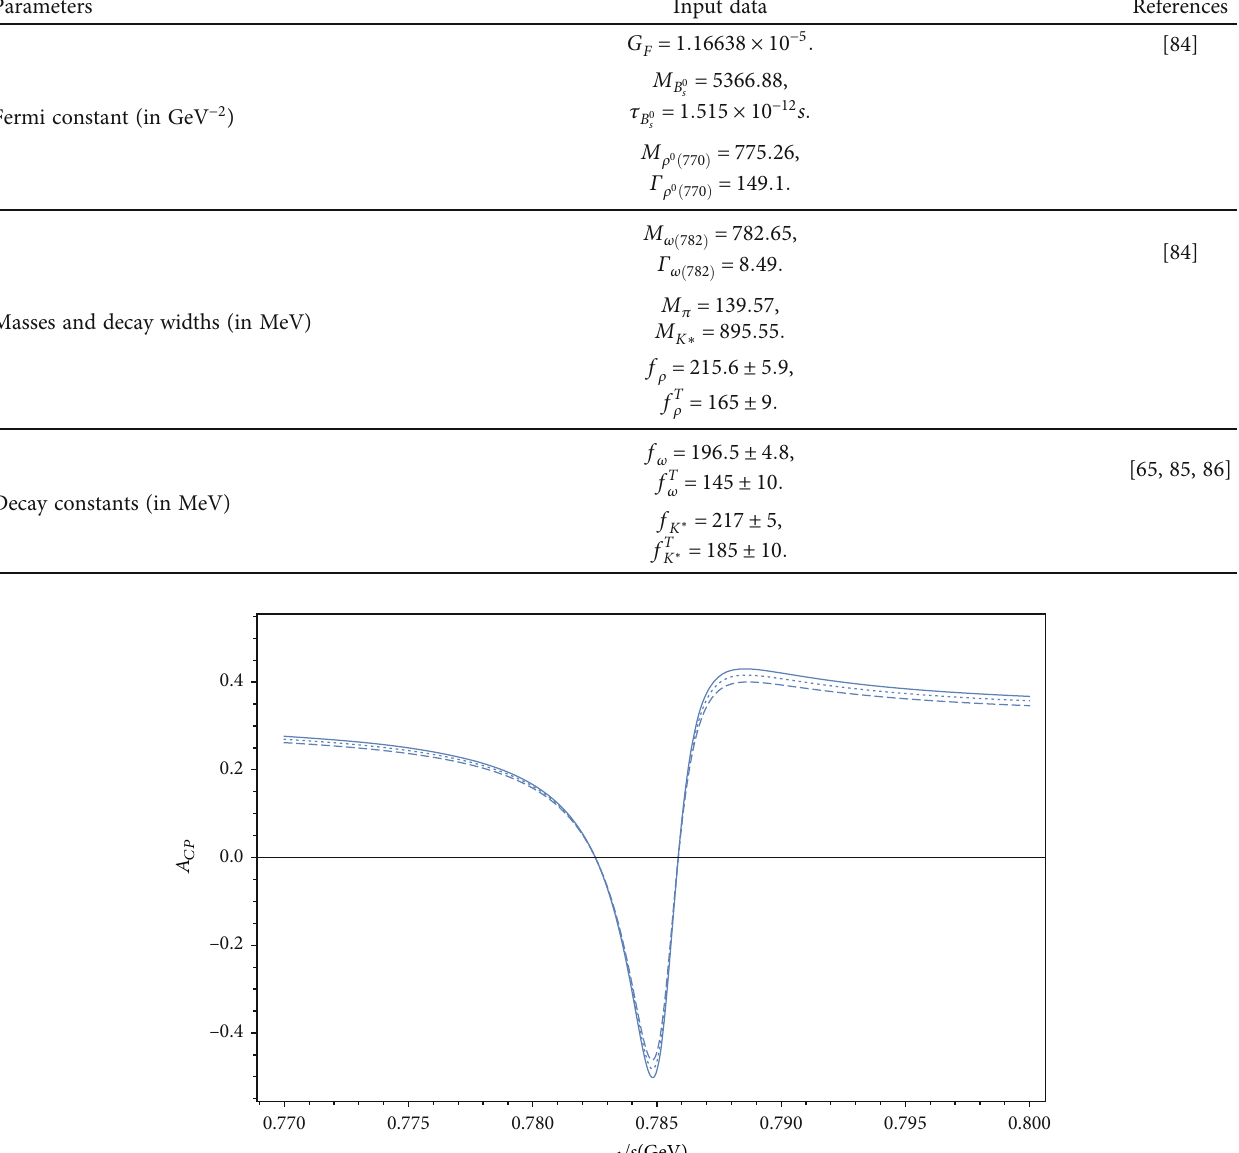
Table 1: Input parameters.